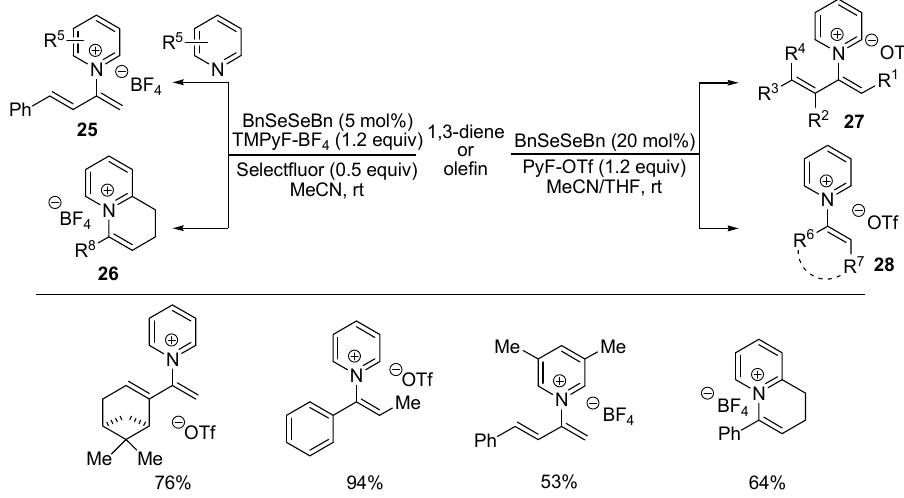
Scheme 11. Organoselenium-catalyzed regioselective pyridination of 1,3-dienes.